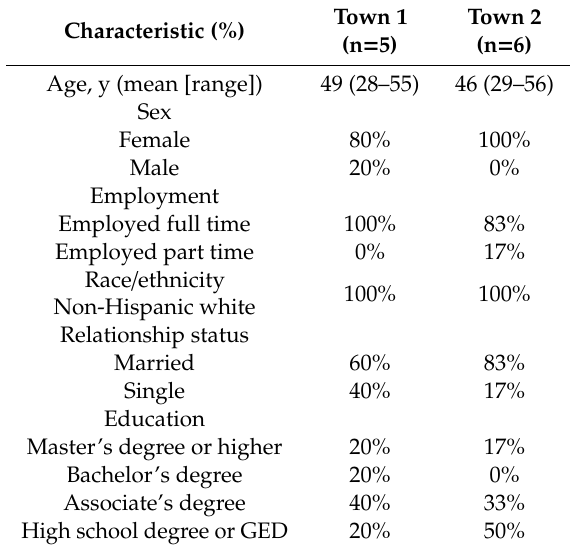
Table 3. Sociodemographic characteristics of eHEART participants at baseline.